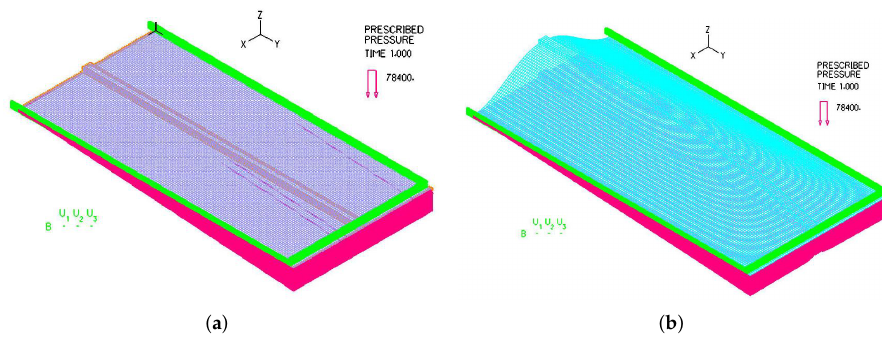
Figure 6. A typical three-dimensional solid ADINA model. ( a ) Solid model, ( b ) Results.